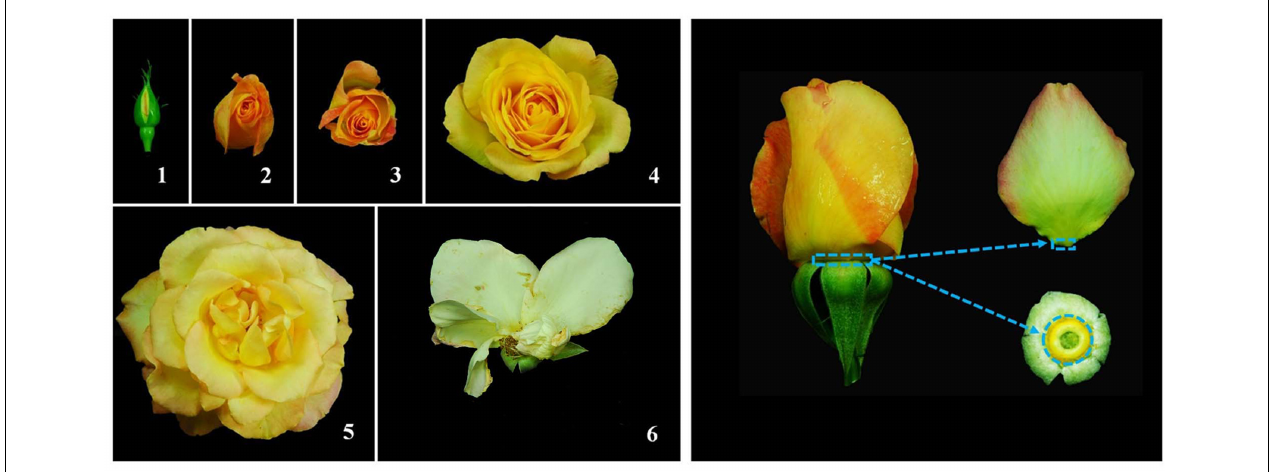
FIGURE 1 | Flower opening stages in rose (Left), and petal abscission zone region used for RNA-Seq (Right). (Left) flower opening of rose was divided into six stages: stage 1, partially opened bud; stage 2, completely opened bud; stages 3 and 4, partially opened flower; stage 5, fully opened flower with visible anthers; stage 6, fully opened flower with abscised petals. (Right) abscission zone (AZ) sample used for RNA-Seq was the AZ at the base of petal (less than 1 mm in length) and AZ at the receptacle where petals locate (less than 1 mm in length).